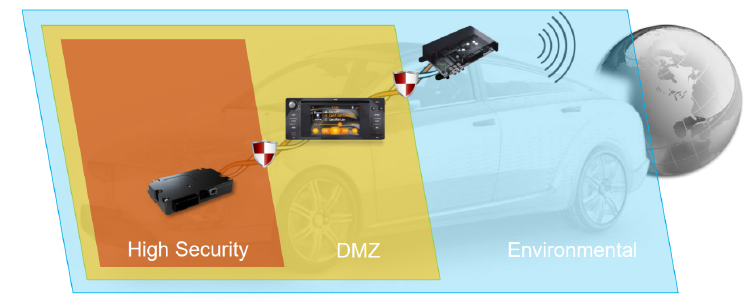
Figure 19. Representation of SEIS Zone Model with Three Zones